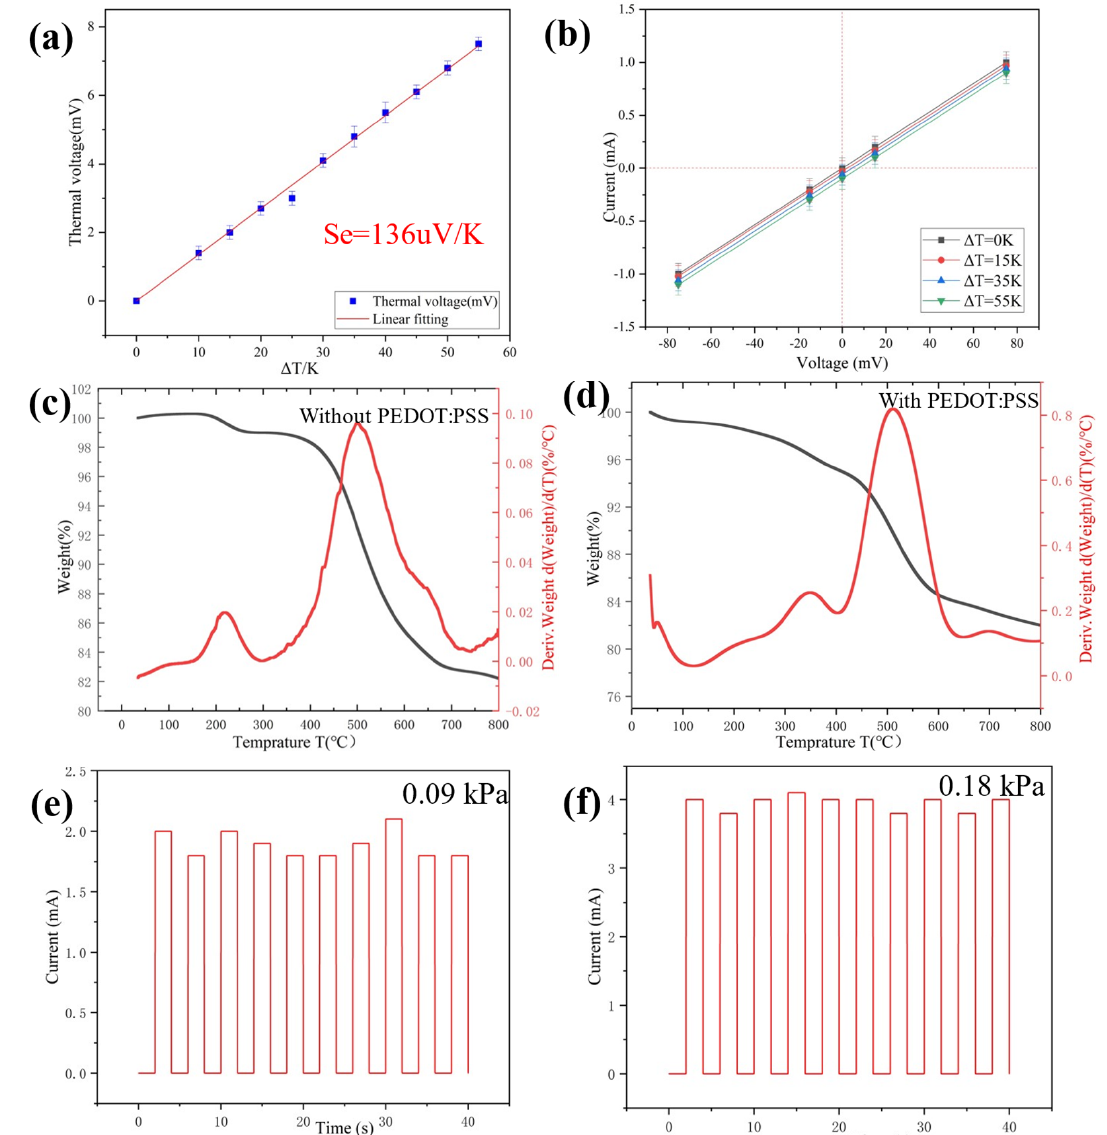
Figure 4. ( a ) Thermal voltage change with different temperature gradients; ( b ) I - V curves of the multiparameter sensor device under various temperature gradients. ( c , d ) TG - DTG curves of silica aerogel without PEDOT:PSS and with PEDOT:PSS; ( e , f ) Test of repeatability of 10 cycles for the pressure sensor after baking at 100 °C for 30 min.